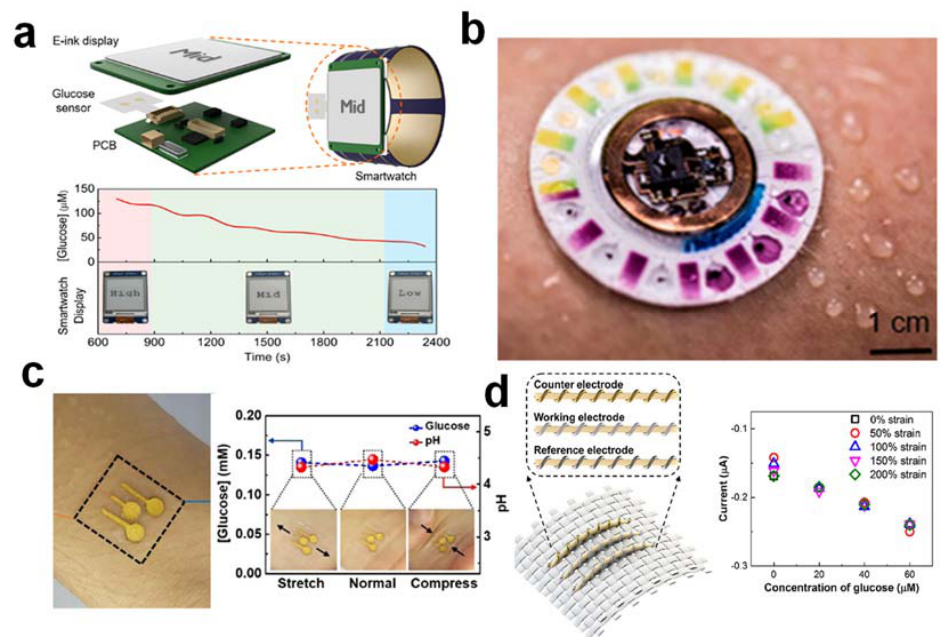
Figure 3. ( a ) It is a fully integrated, self-powered smartwatch for continuous sweat glucose monitoring. ( b ) It is a skin-interfaced, battery-free microfluidic system for electrochemical, colorimetric, and volumetric sweat analysis. ( c ) It is a skin-attachable and stretchable electrochemical sweat sensor for glucose and pH detection. ( d ) It is a fiber-based electrochemical wearable biosensor that is highly stretchable and strain ‐ insensitive for monitoring sweat glucose. The figures are reprinted with permission from ref [25,28,29,31].